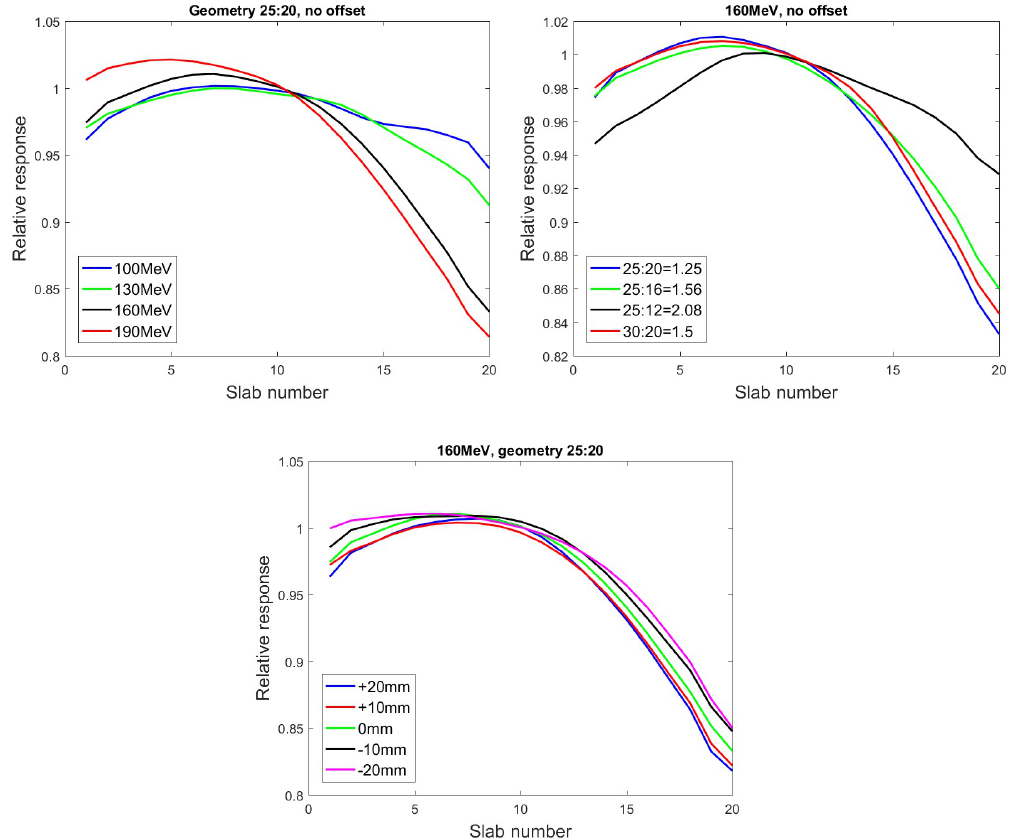
Figure 5. Geometrical correction as function of beam energy ( top left ), camera setup ( top right ) and offset along beam axis ( bottom ).